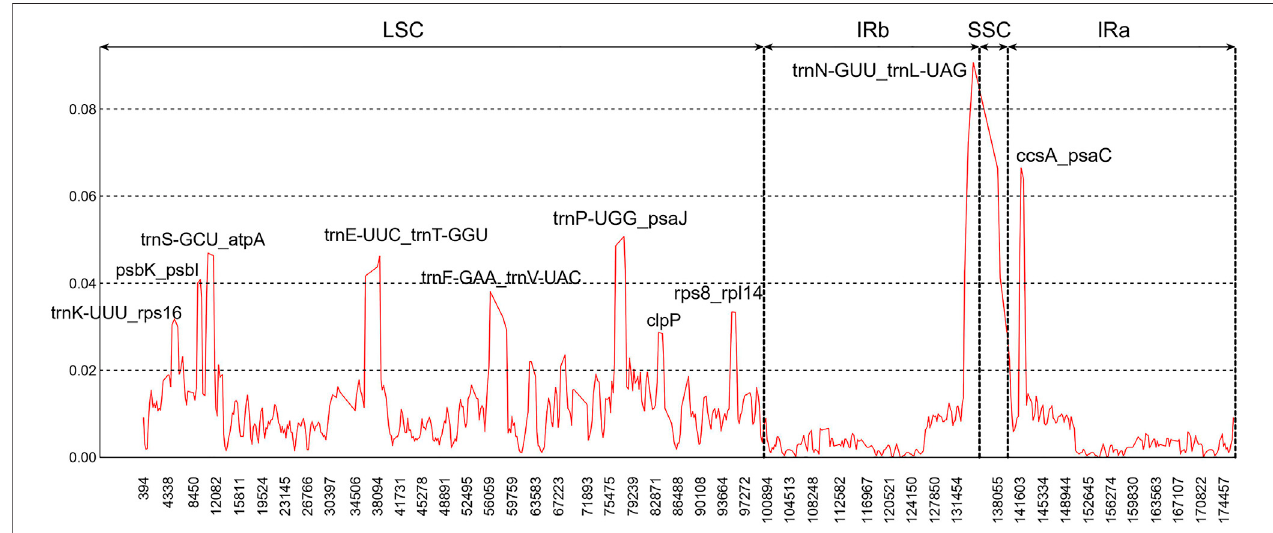
FIGURE 4 | Sliding window analysis of the nine Paphiopedilum chloroplast genomes (window length: 600 bp, step size: 200 bp). x-Axis, the window midpoint; y-axis, nucleotide diversity (Pi).